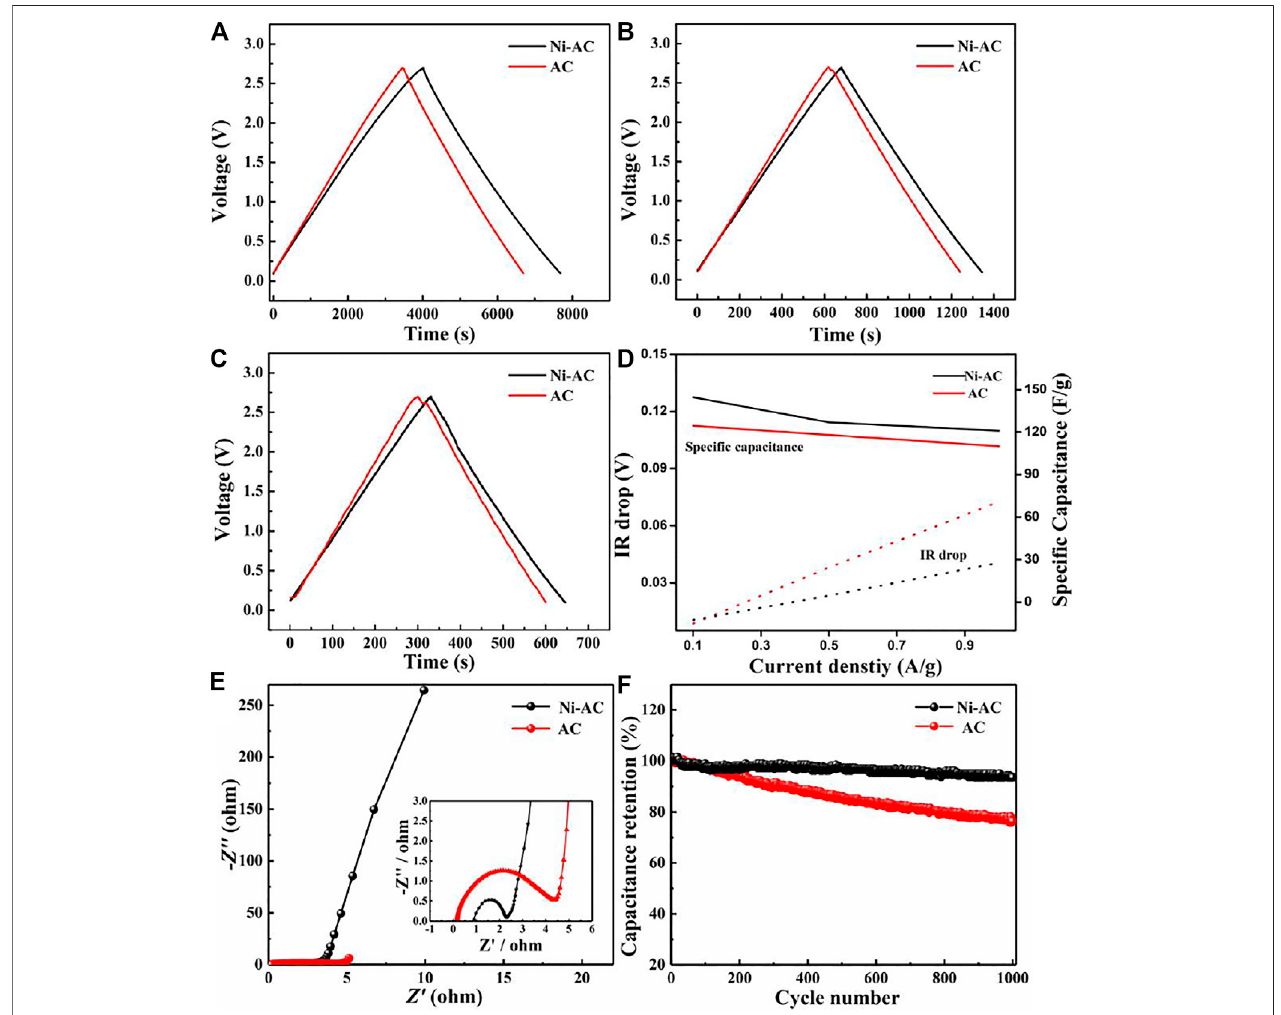
FIGURE 4 | The galvanostatic charge-discharge curves at 0.1 (A) , 0.5 (B) , and 1 A g − 1 (C) , and the speci fi c capacitance and IR drop under different current densities (D) , Nyquist plots (E) , and cycle performance (F) of the Ni-AC and AC electrodes.